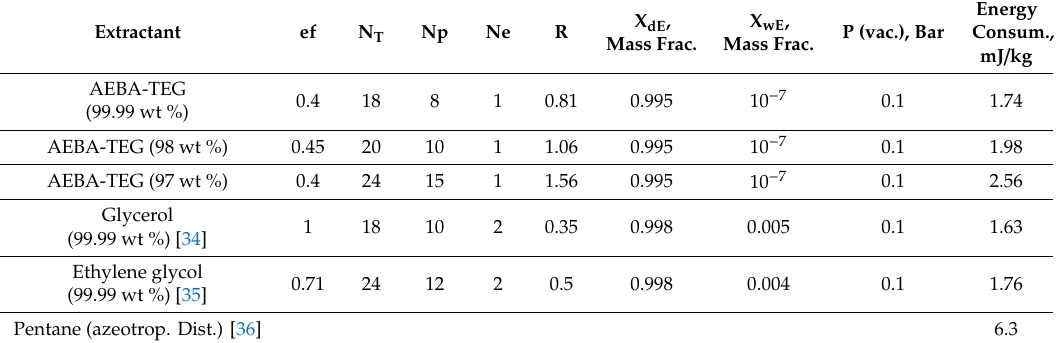
Table 2. Results of modeling the process of ethyl alcohol separation from an aqueous